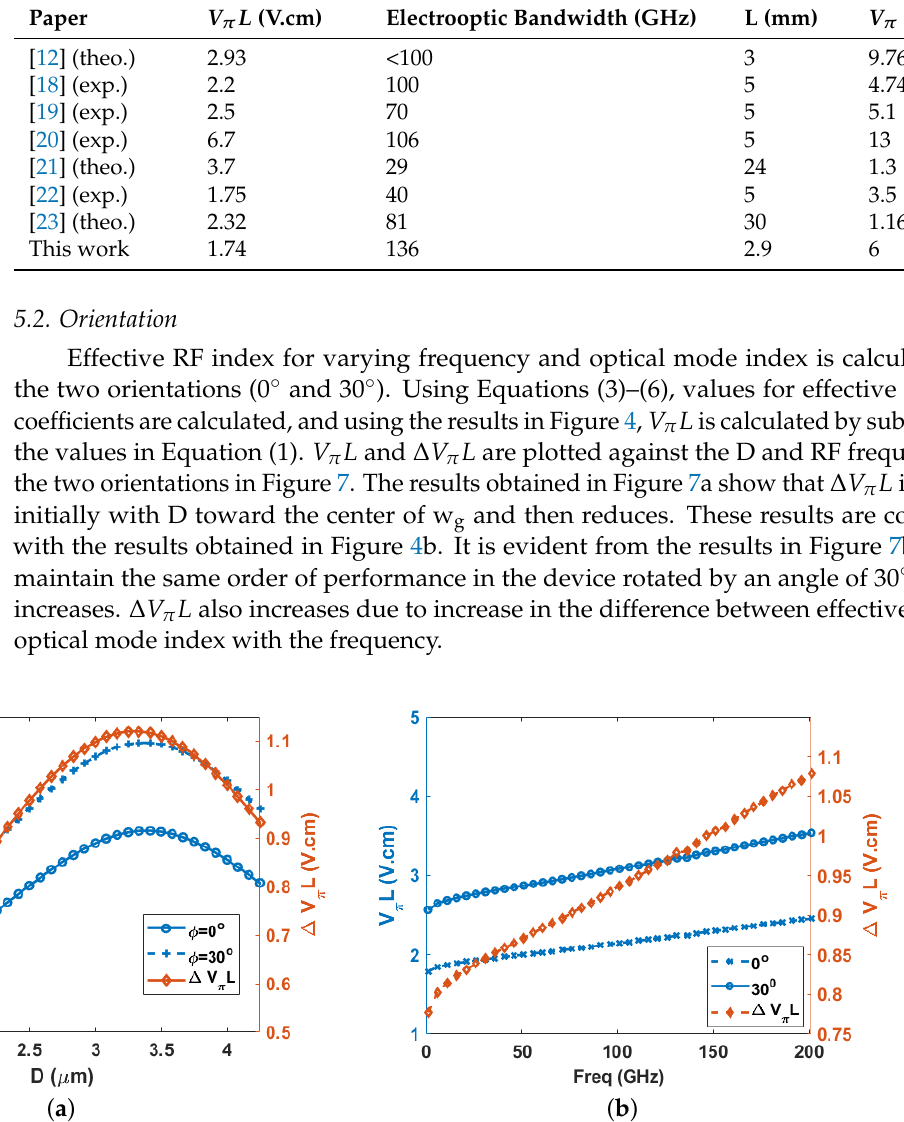
Table 2. Performance comparison of various CPW-based TFLN modulators.